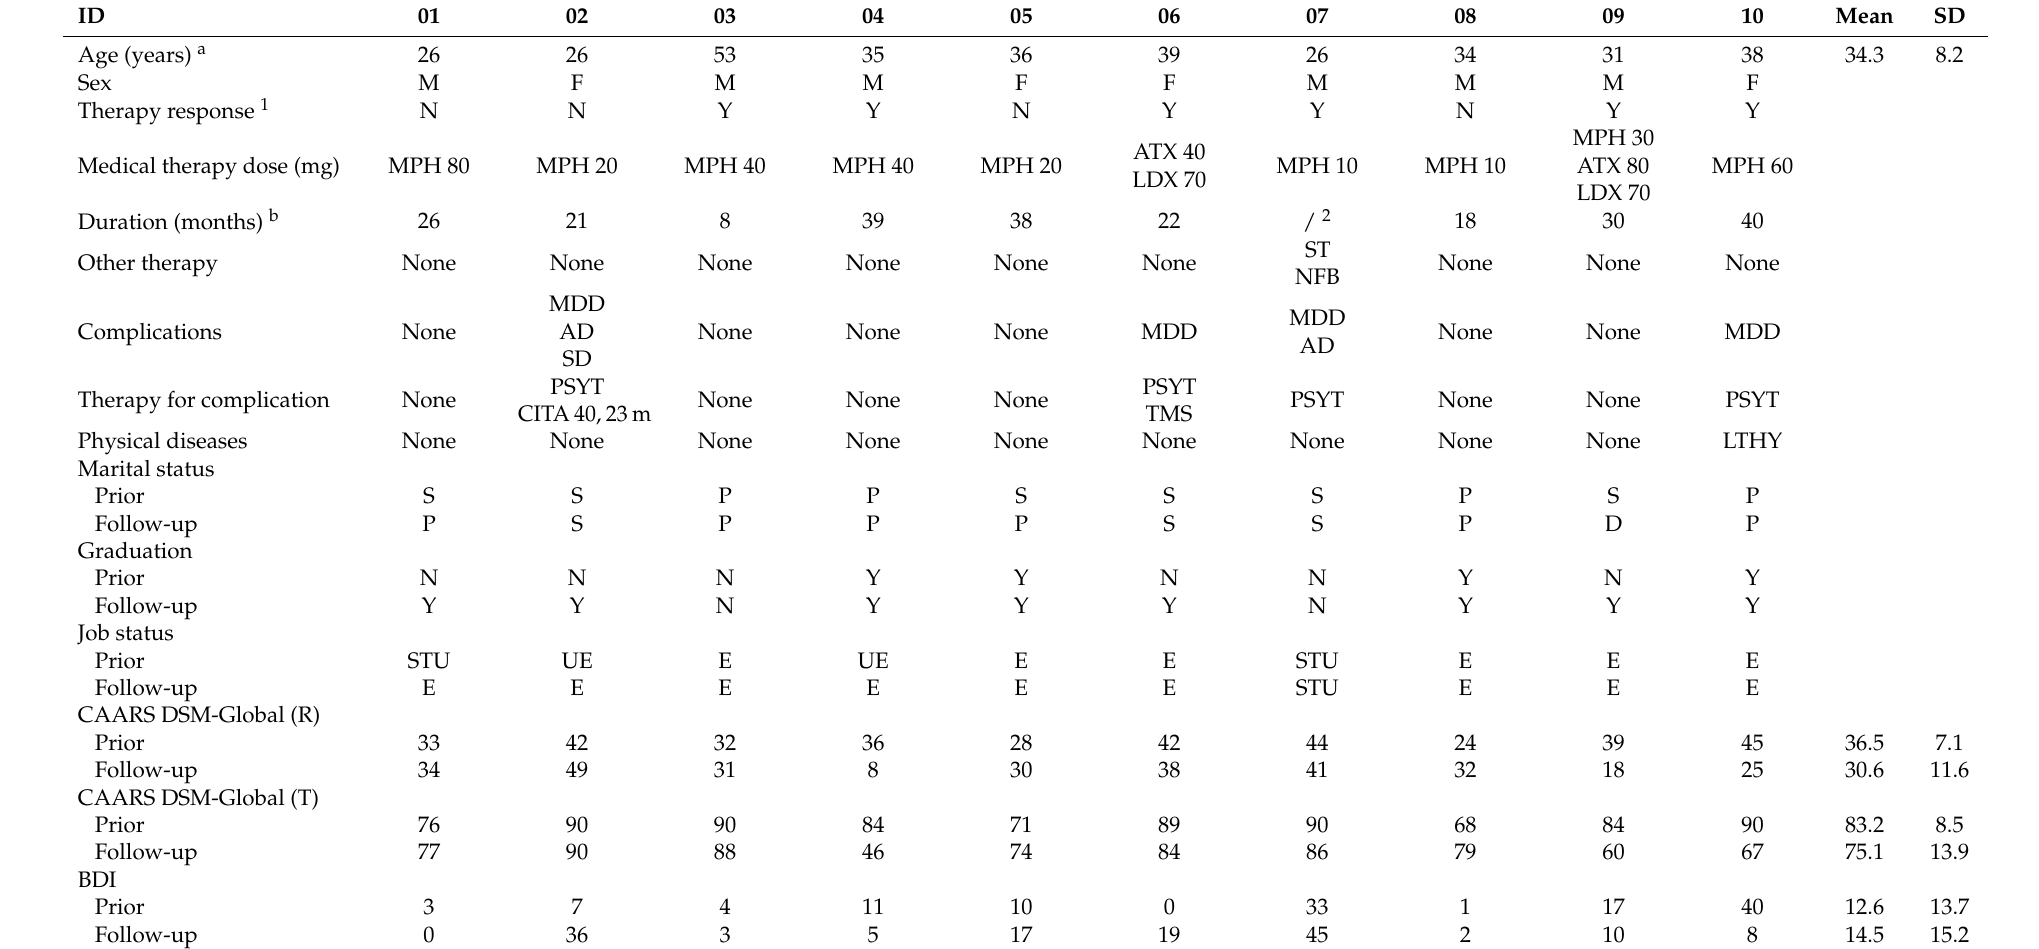
Table 1. Demographic and related clinical profiles of adults with ADHD prior to the study and at